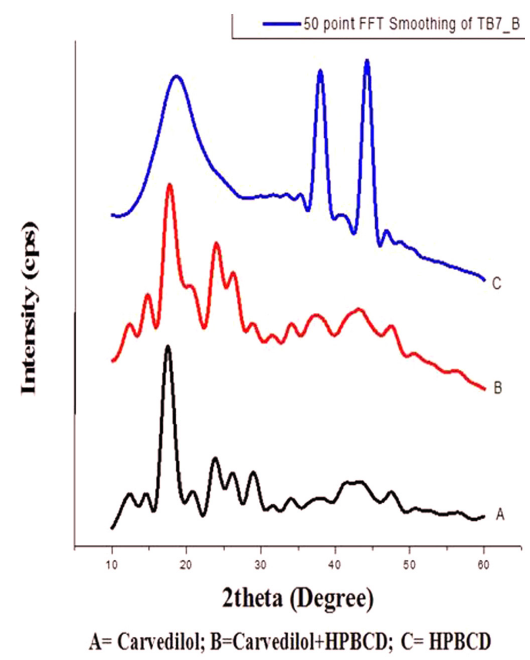
FIGURE 7 - X-ray diffractograms of Physical mixtures carvedilol with HPBCD in a ratio of 1:1.